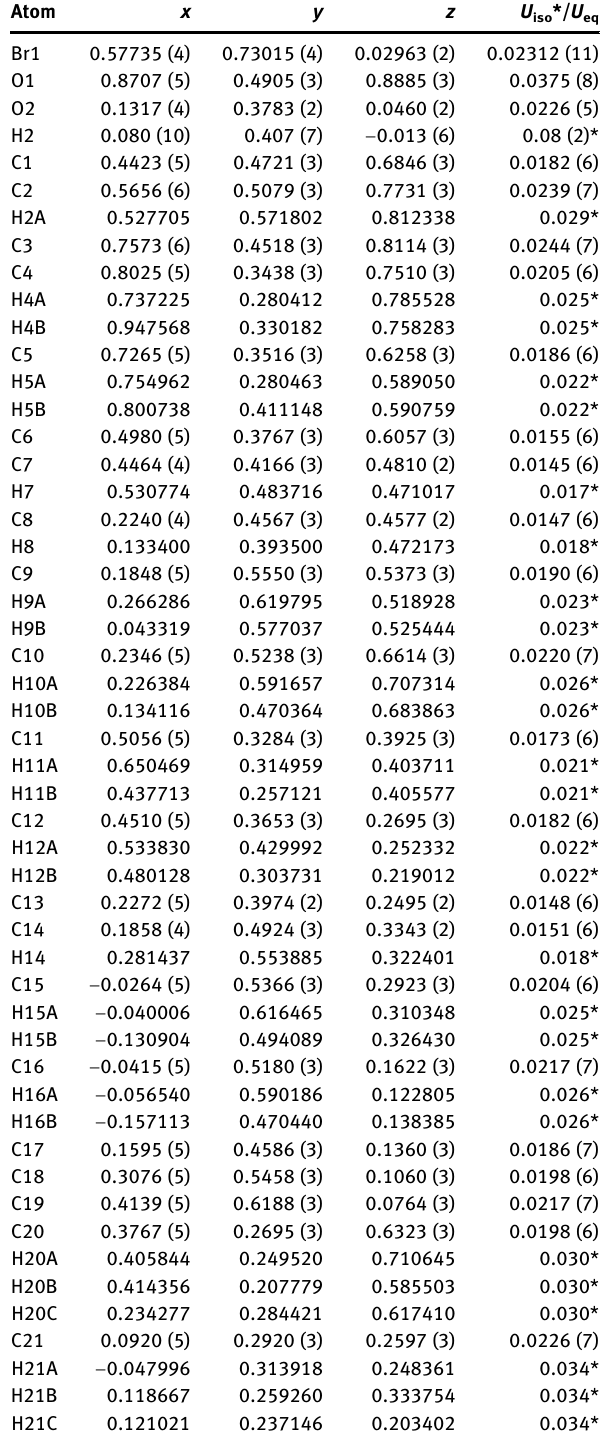
Table  : Fractional atomic coordinates and isotropic or equivalent isotropic displacement parameters (Å 